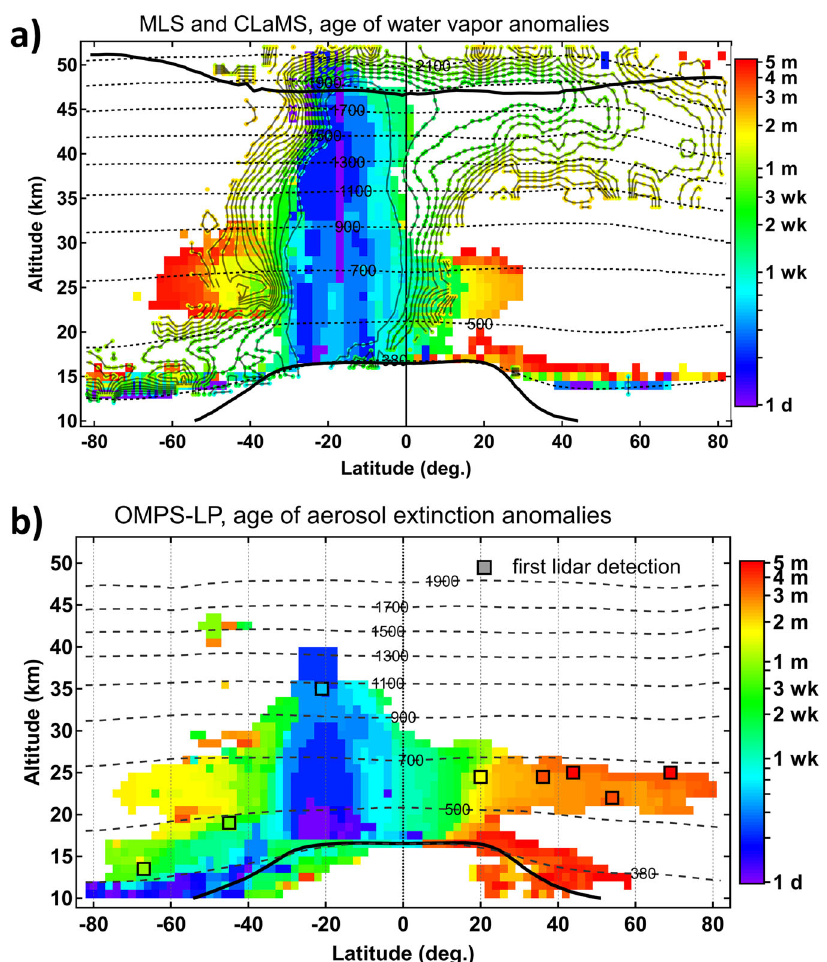
Fig. 6 Global dispersion of water vapour and aerosol plumes during 5 months since Hunga eruption. a Poleward dispersion of hydrated plumes detected by MLS V5 with WVMR climatological anomalies exceeding 3 ppmv. The pixels are colour-coded by the age of hydrated layers since 15 January 2022. The contours (age colour-coding) represent the results of CLaMS model simulation of hydrated plumes transport (WVMR anomalies above 3 ppmv). The initial extent of the wet anomaly in the CLaMS simulation (initialised with MLS V5 data on 18 January) is represented by the inner isoline. Thick solid curves mark the tropopause and the stratopause, thin dashed curves indicate isentropic levels. b Same as A but for OMPS-LP detections of aerosol layers with extinction ratios exceeding 3. The black rectangles with age-dependent colour meshing indicate the fi rst aerosol layer detections by ground-based lidars (Fig. S4 and Supplementary notes